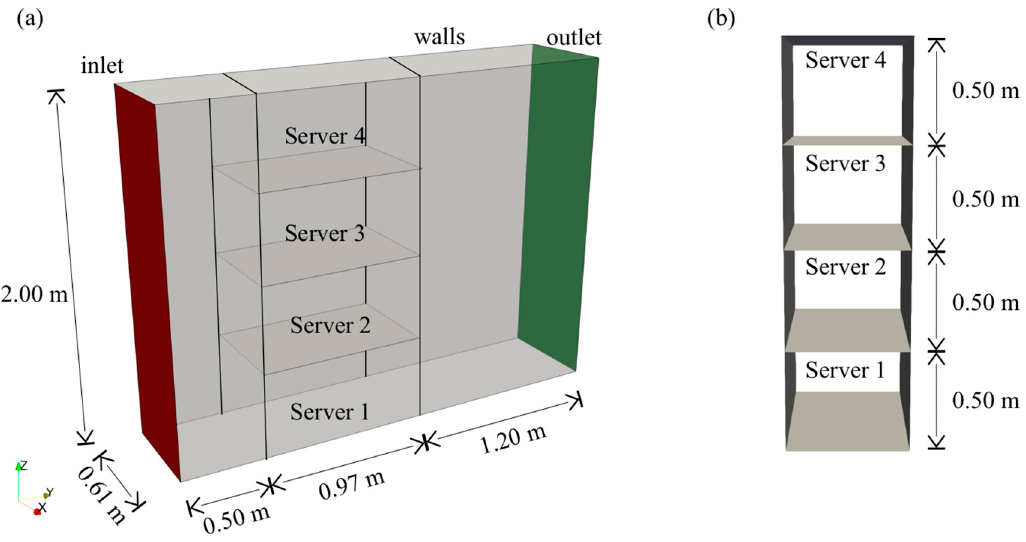
Figure 17. Three-dimensional views of ( a ) computational domain with boundaries and ( b ) server cabinet.